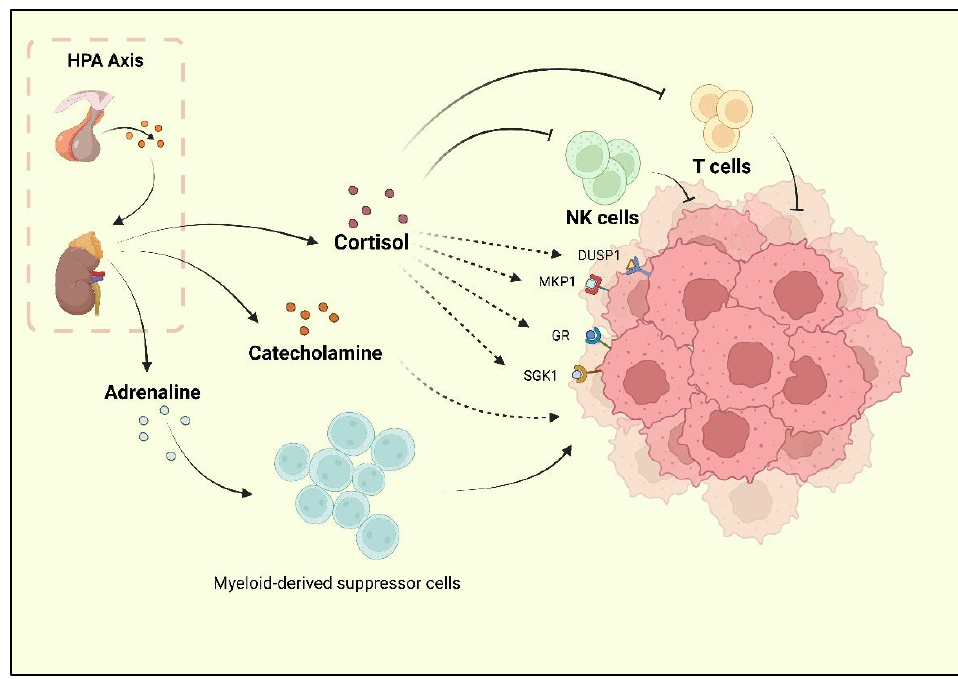
Figure 1. The HPA axis activated by stress is reported to promote cortisol, adrenaline, and catecholamine release. Cortisol could inhibit the activity of NK cells and T cells, as well as promote the activation of GR, MKP1, SGK1, and DUSP1, which are the positive factors for breast cancer progres- sion. Catecholamine also plays a promoting role for BC. Moreover, adrenaline could upregulate the bioactivity of MDSCs, which indirectly promote the progression of BC.